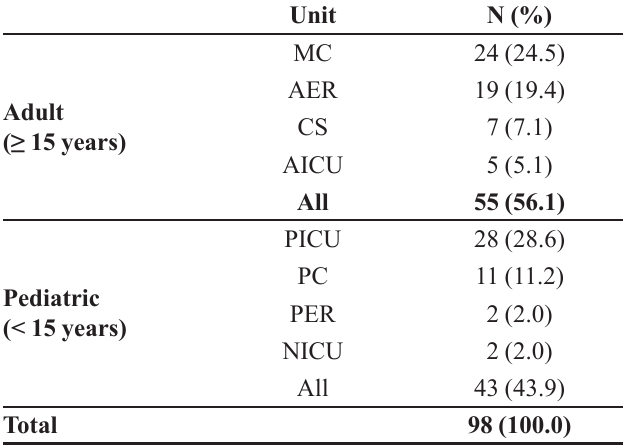
TABLE II - Requests for human albumin, per admission unit (HU-USP, from January to October